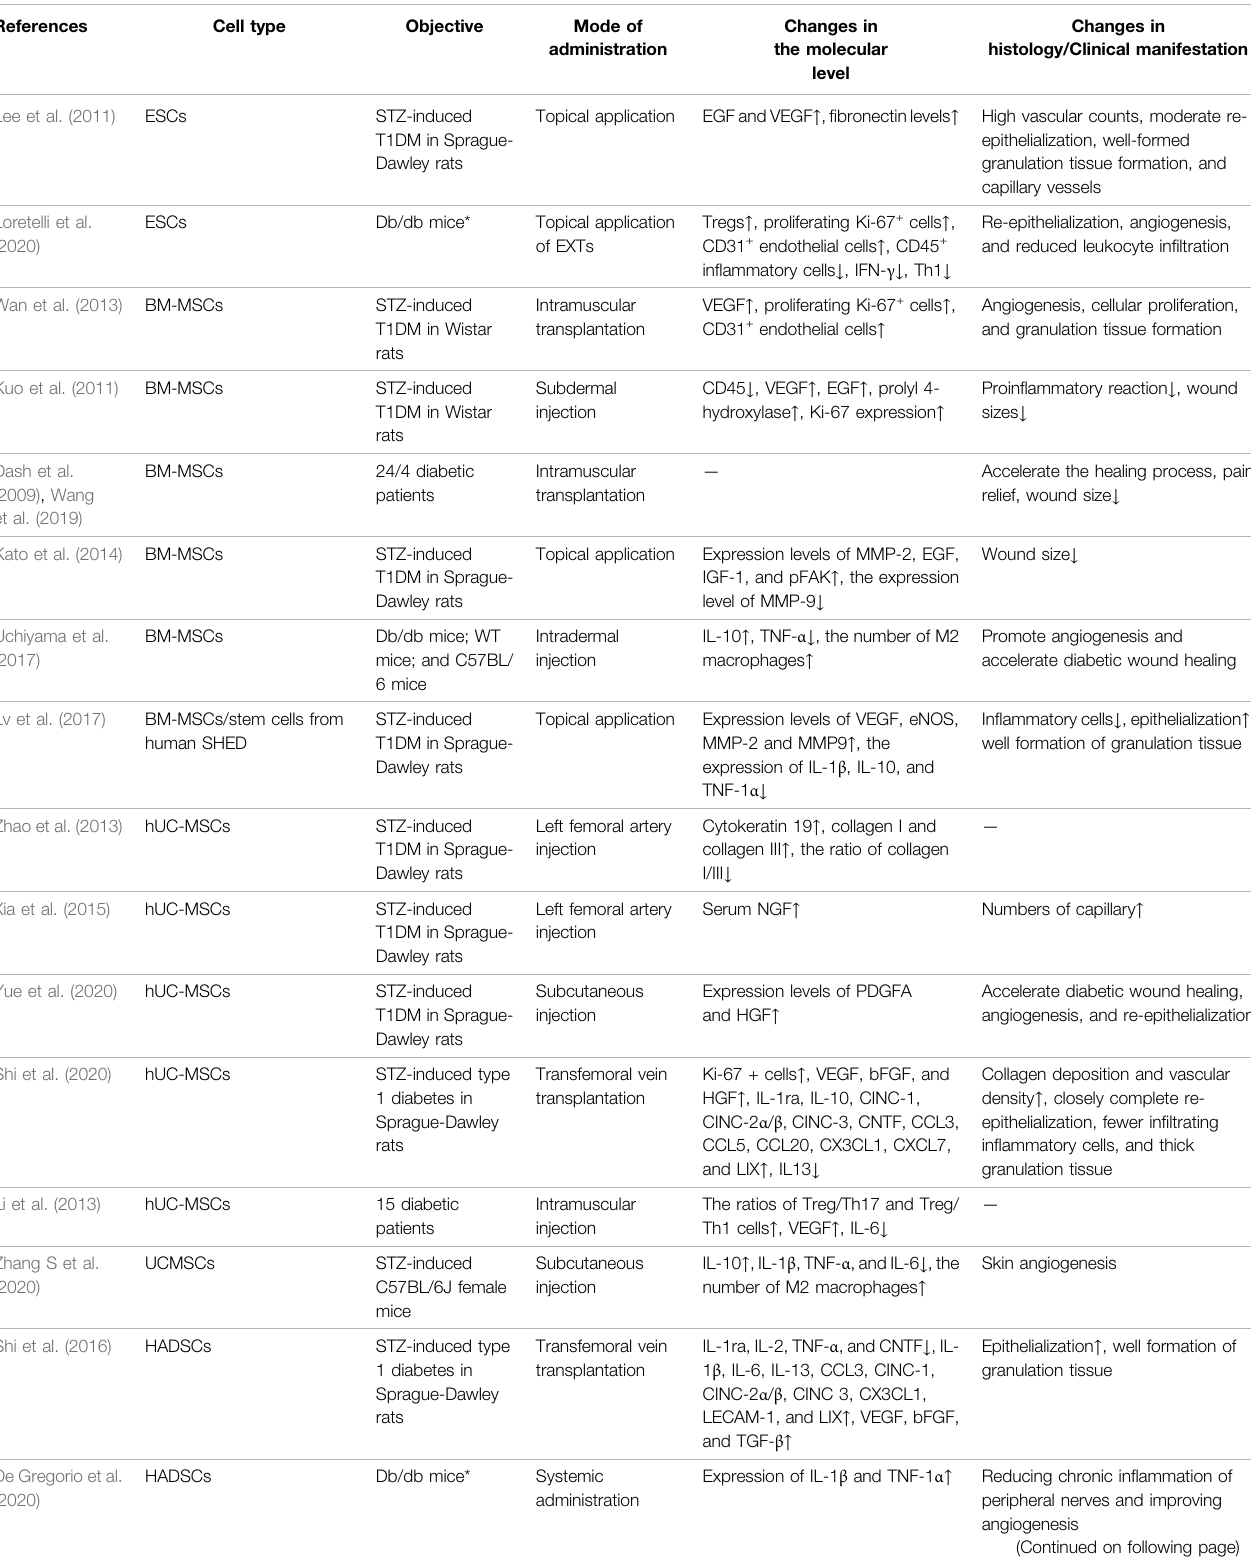
TABLE 1 | Potential role of stem cells in the healing process of